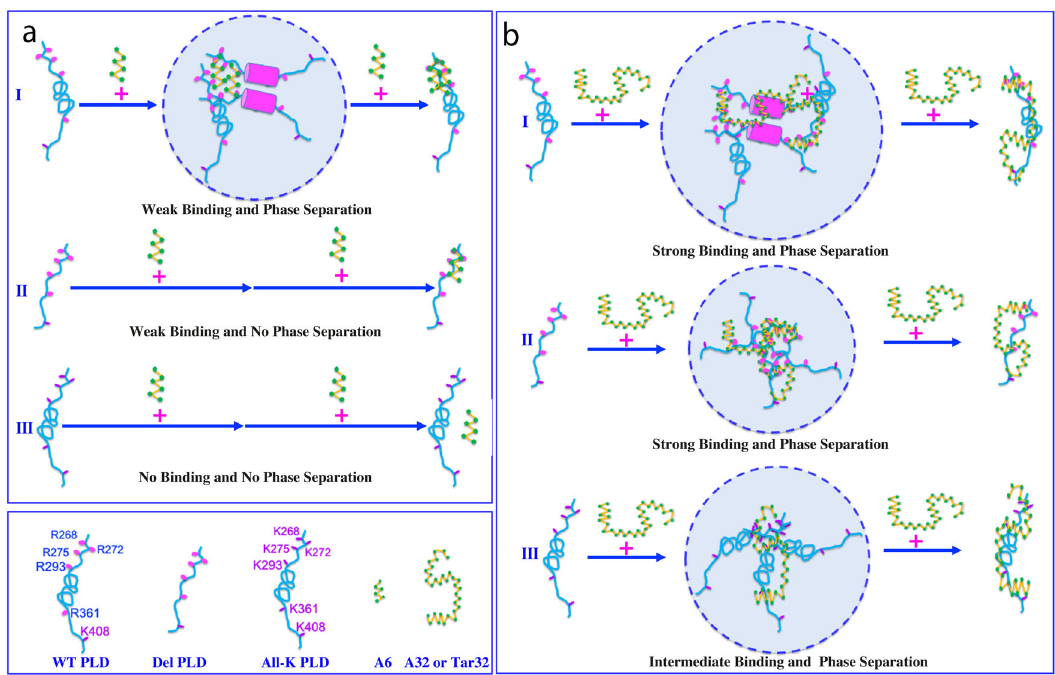
Fig. 5 Speculative mechanisms for three ssDNAs to three PLDs to modulate LLPS. a Interactions of A6 to three PLDs. (I) For WT-PLD, A6 multivalently binds its clustered Arg268, Arg272, and Arg275 of several WR-PLD molecules to form large and dynamic A6-PLD complexes manifesting as liquid-like droplets, which is coupled with the intrinsic driving force via the oligomerization-induced formation of helices (purple cylinder) over the hydrophobic region. However, with further addition of an exceeding amount A6, LLPS is disrupted. (II) For Del-PLD, A6 is still able to multivalently bind its clustered Arg268, Arg272, and Arg275 but is no longer able to drive LLPS due to the deletion of the hydrophobic region. (III) For AllK-PLD, A6 is no longer able to tightly bind its residues as well as unable to drive LLPS due to the low binding af fi nity of Lys residues with nucleic acids. b Interactions of Tar32/A32 to three PLDs. (I) For WT-PLD, Tar32/A32 multivalently binds not only the clustered Arg268, Arg272, and Arg275, but also Arg293, Arg361, and Lys408 to form large and dynamic Tar32/A32 – PLD complexes manifesting as liquid-like droplets, which is coupled with the intrinsic driving force via the oligomerization-induced formation of helices (purple cylinder) over the hydrophobic region. With the further addition of an exceeding amount Tar32/A32, LLPS is disrupted. (II) For Del-PLD, the multivalent binding of Tar32/A32 to the clustered Arg268, Arg272, and Arg275, as well as Arg293, Arg361, and Lys408 are suf fi cient to form large and dynamic Tar32/A32 – PLD complexes manifesting as liquid-like droplets despite the lack of the intrinsic driving force. With the further addition of an exceeding amount Tar32/A32, LLPS is disrupted. (III) For AllK-PLD, the multivalent binding of Tar32/A32 to